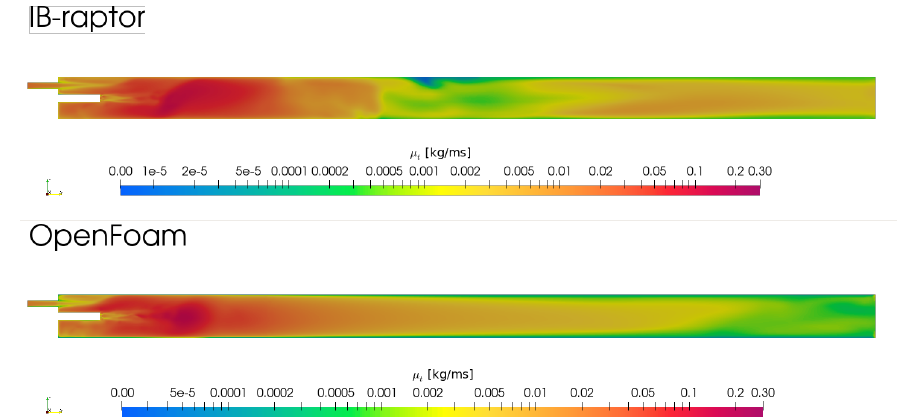
Figure 4. Clipped eddy viscosity ratio in kg/ ( ms ) computed by: IB-Raptor ( top ); and rhoSimpleFoam ( bottom